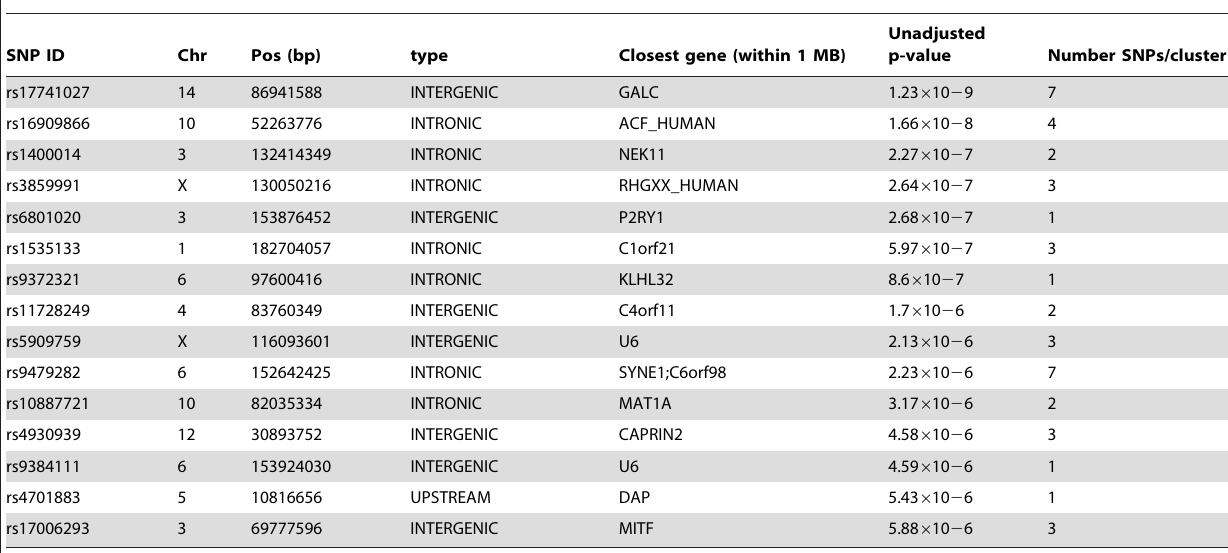
Table 2. Results from GWAS for the KORA-GenCord